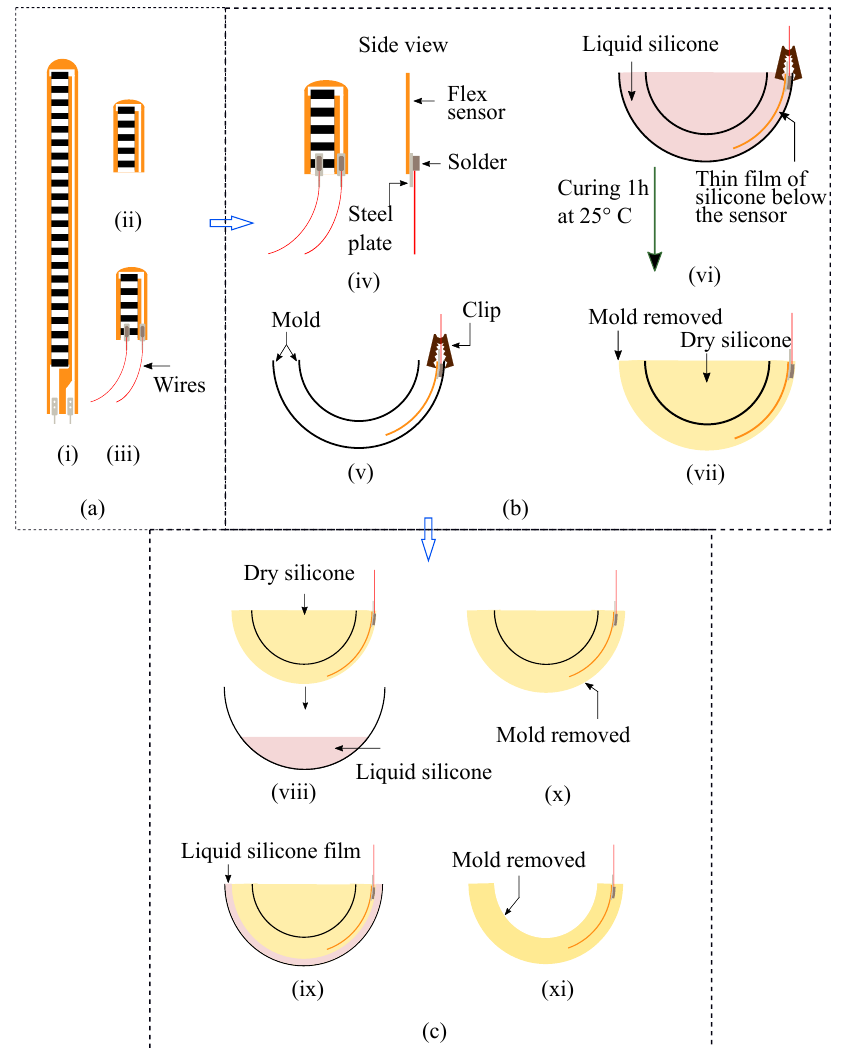
Figure 2. Schematic diagram of the step-by-step fabrication process of the flex sensor-based multi- directional force sensing system: ( a ) flex sensor preparation; ( b ) placing the flex sensors inside the mold; ( c ) creating a thicker outer layer over the flex